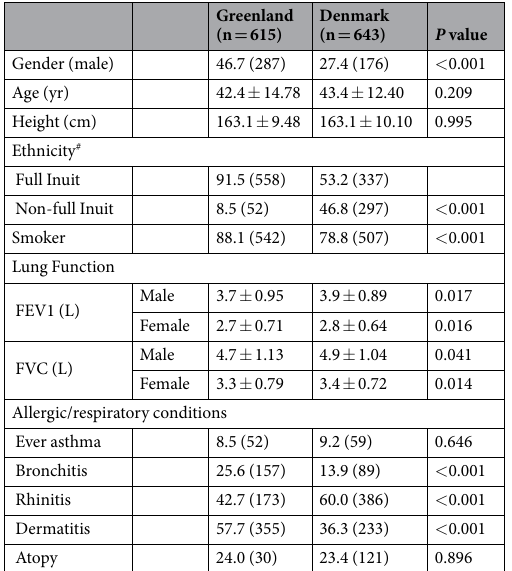
Table 1. Demographic and phenotypic data for Inuit residing in Greenland and Denmark. Data are presented as Mean ± SD or % (n); # Full Inuit means that all 4 grandparents are Inuit; Non-full Inuit means at least 1 non- Inuit